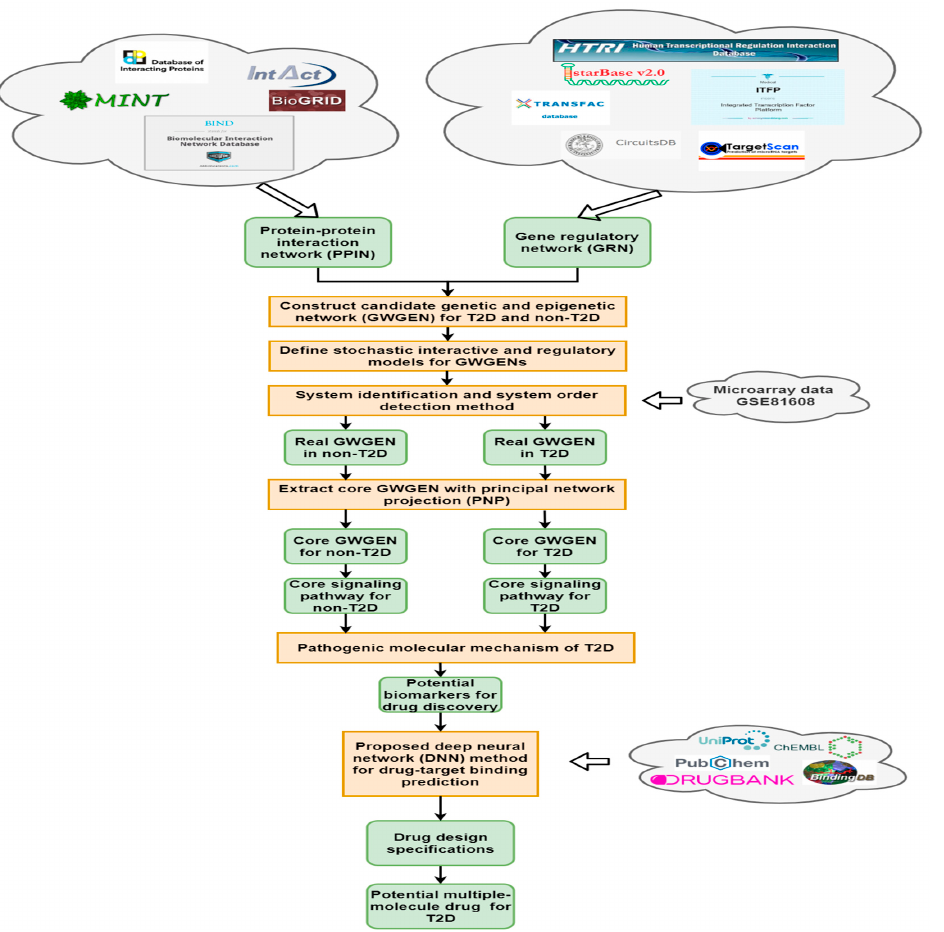
Figure 1. Flowchart of systems biology method and the outline of systematic drug discovery design. The candidate genome-wide genetic and epigenetic networks (GWGEN) consist of gene regulation network (GRN) and protein–protein interaction network (PPIN), where candidate GRN was constructed through integrating gene regulation databases and candidate PPIN was constructed via protein–protein interaction databases. The candidate GWGENs were identified to obtain real GWGENs by RNA-seq data from GSE81608 through system identification and system order detection. Then, core GWGENs were extracted from real GWGENs by the principal network projection (PNP) method. Potential drugs were discovered according to the significant biomarkers determined by investigating the T2D pathogenesis constructed through comparing core signaling pathways of non-type 2 diabetes (T2D) and T2D.